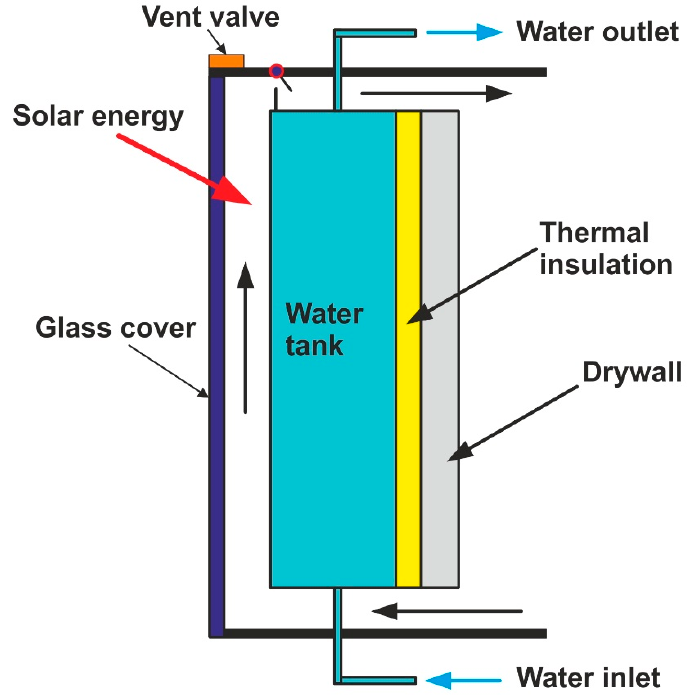
Figure 1. Schematic diagram of the modified Trombe wall .